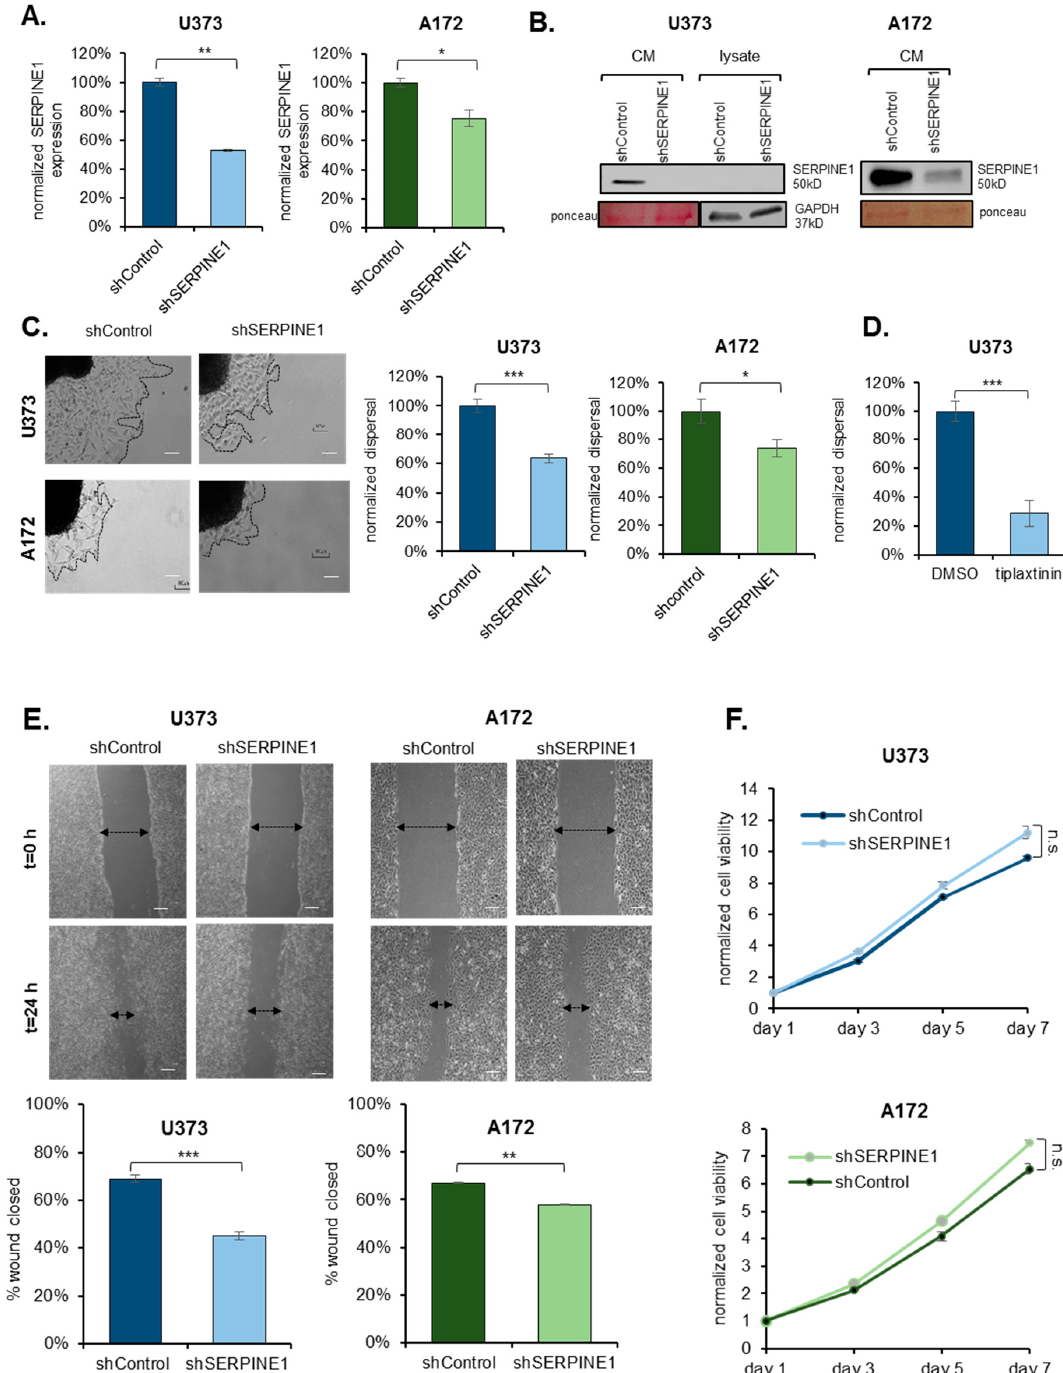
Figure 2. SERPINE1 knock-down reduces GBM dispersal ( A ) qRT-PCR analysis of SERPINE1 expression levels after shRNA knock-down; ( B ) SERPINE1 protein levels after shRNA knock-down; ( C ) dispersal assay that shows SERPINE1 knock-down reduces dispersal of U373 and A172 spheroids significantly ( n = 24 spheroids for each condition, scale bar: 200 µm); ( D ) dispersal assays that shows chemical inhibitor of SERPINE1, tiplaxtinin, reduces dispersal of U373 spheroids ( n = 12 spheroids for each condition, scale bar: 200 µm); ( E ) wound healing analysis of the effect of SERPINE1 knock-down ( n = 35 areas for each condition, scale bar: 200 µm); ( F ) cell viability analysis of the effects of SERPINE1 knock-down in U373 and A172 cell growth. (*, ** and *** denote p < 0.05, p < 0.01 and p < 0.001 respectively, two-tailed Student’s t -test).